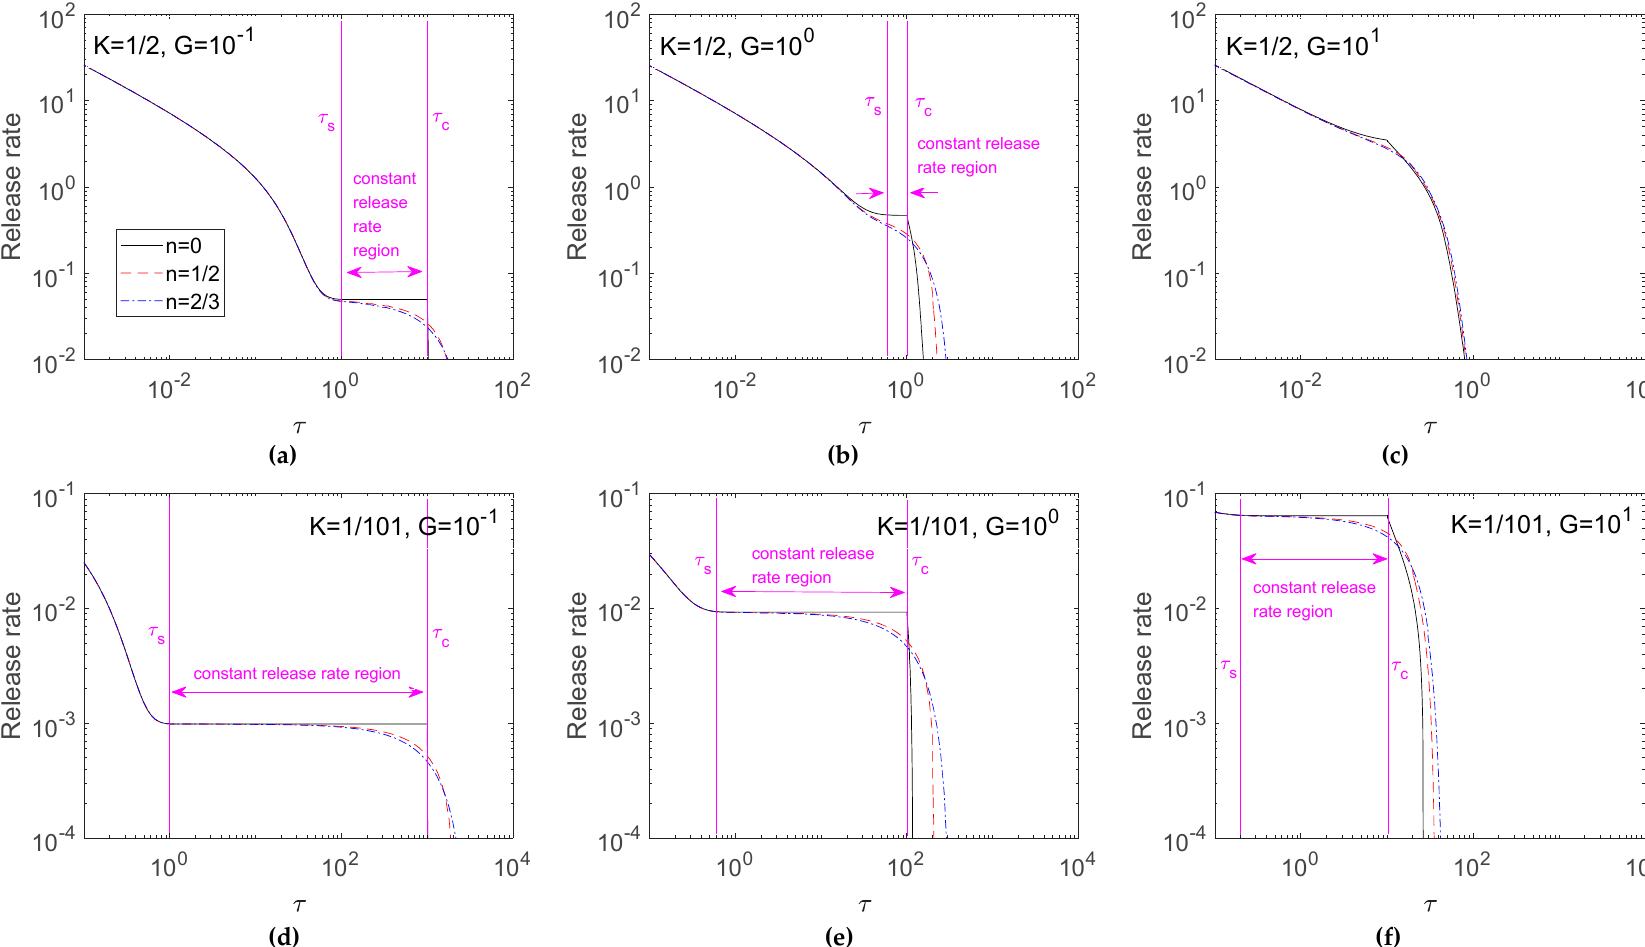
Figure 4. Effect of n on release rates for K = 1/2 ( a – c ) and K = 1/101( d – f ). Calculations are carried out for G = 10 − 1 ( a , d ), 10 0 ( b , e ) and 10 1 ( c , f ).